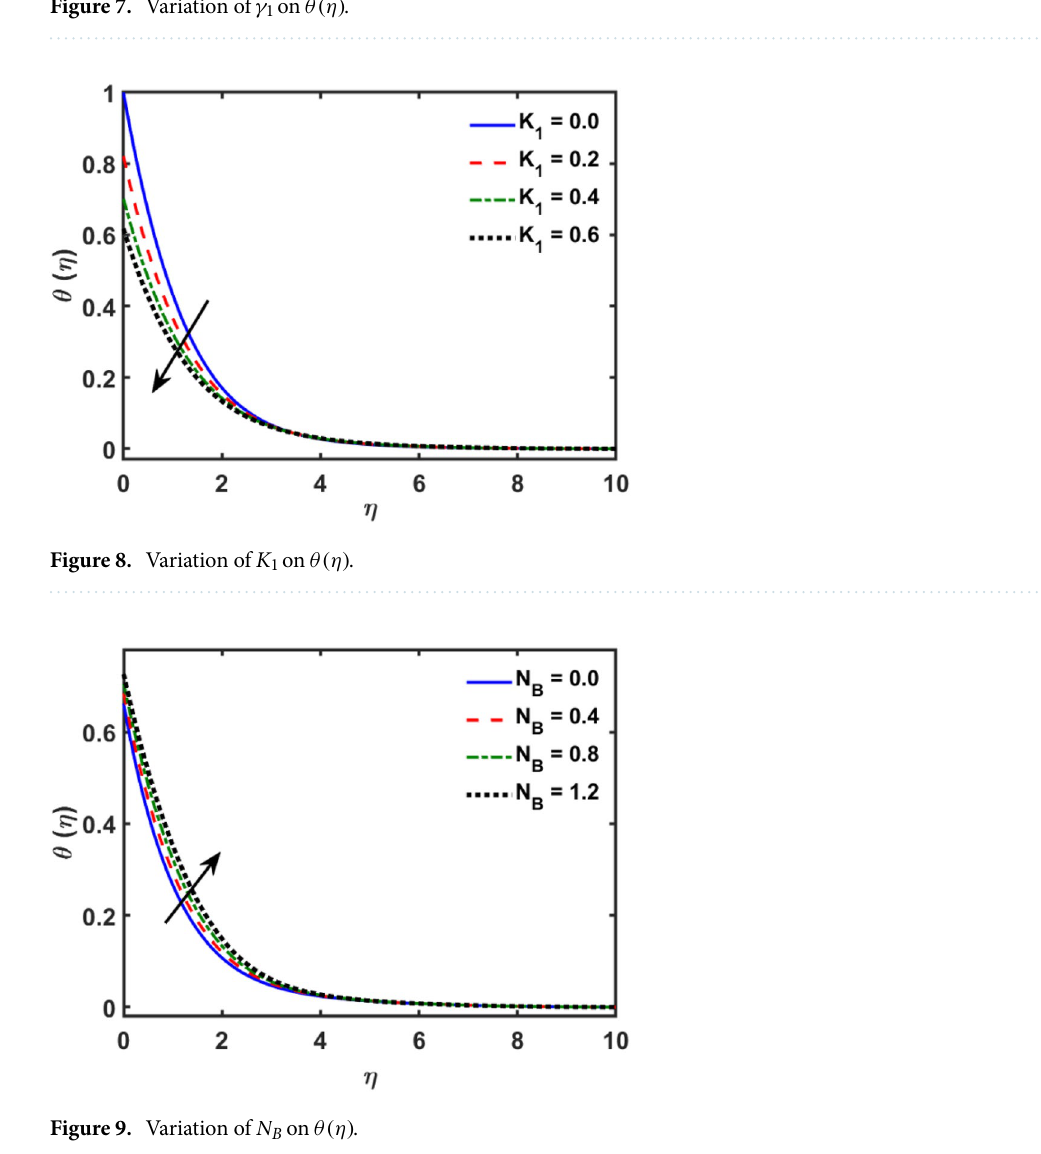
Figure 7. Variation of γ 1 on θ(η) .